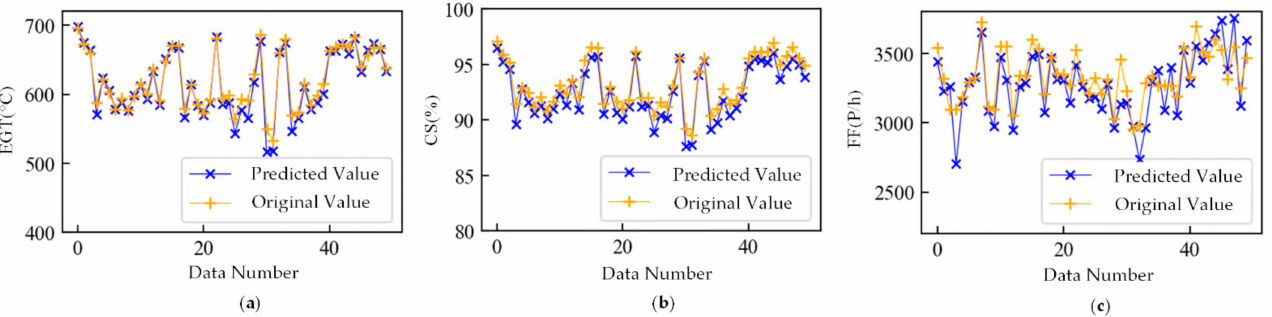
Figure 14. Mining results of the mapping relationship mining model with only a single encoder-decoder. ( a ) The predicted and original values of exhaust gas temperature; ( b ) the predicted and original values of core speed; ( c ) the predicted and original values of fuel flow.